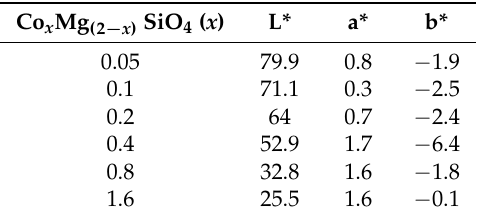
Table 2. CIEL*a*b* data of as-calcined Co x Mg (2 − x ) SiO 4 (where x = 0.05–1.6) powder.